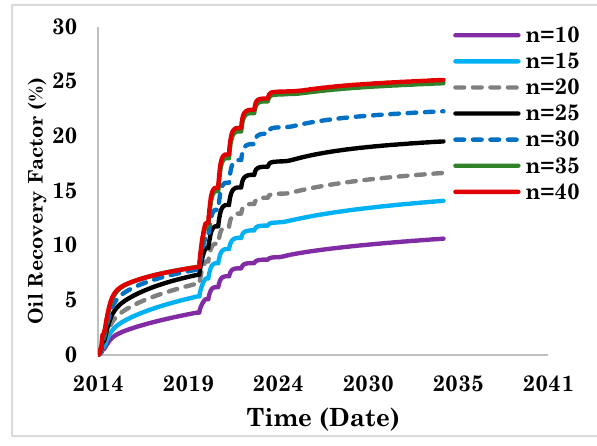
Figure 15. NG Injection (Extended Cycle Size) 38 API Oil.